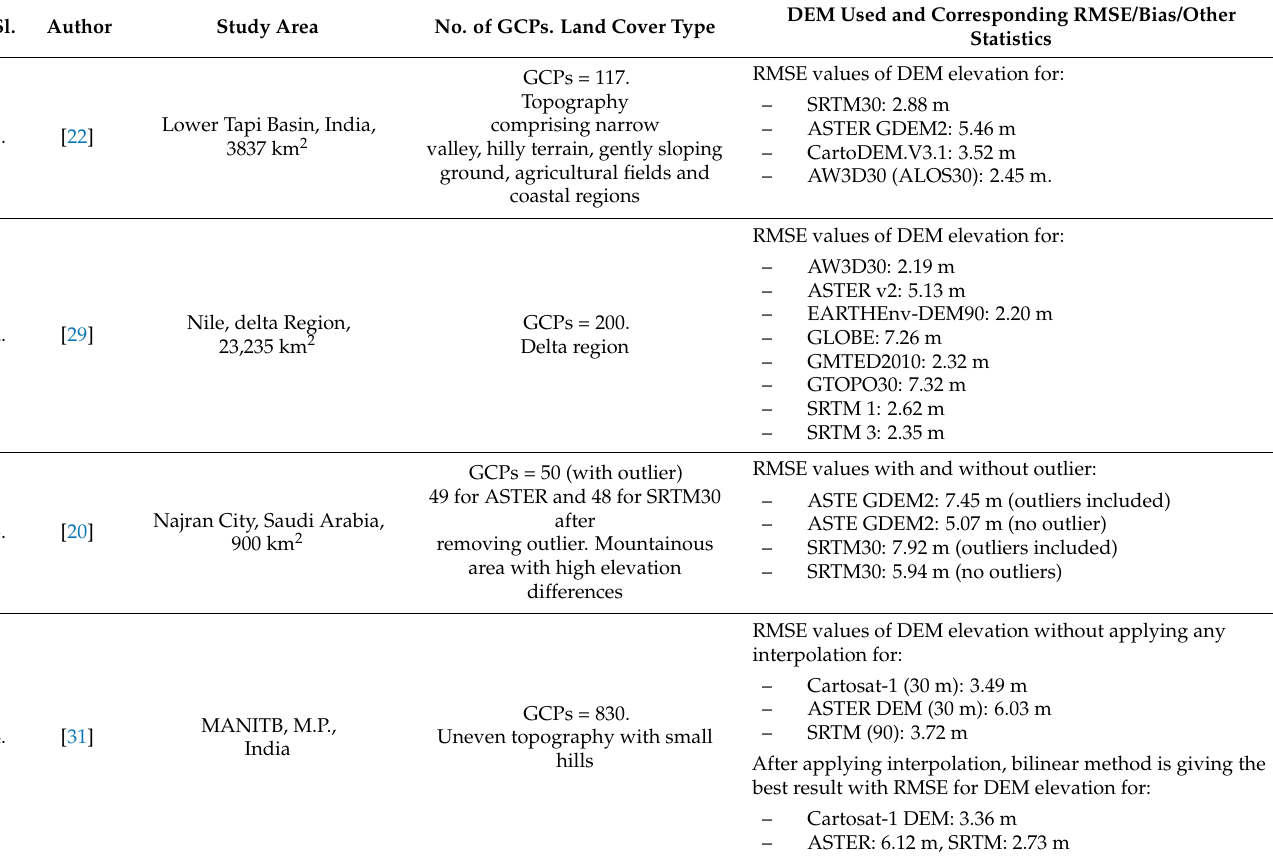
Table 1. Summary of previous studies carried out by researchers worldwide regarding accuracy assessment of elevation obtained from widely used